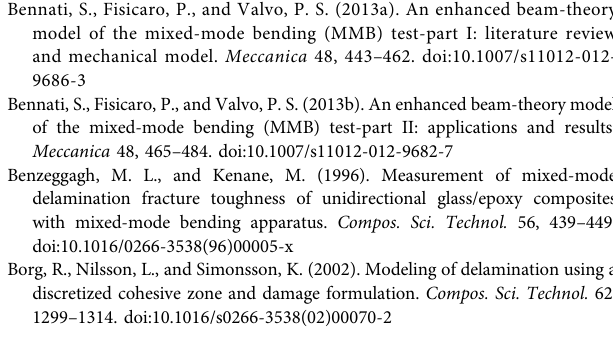
Frontiers in Materials |